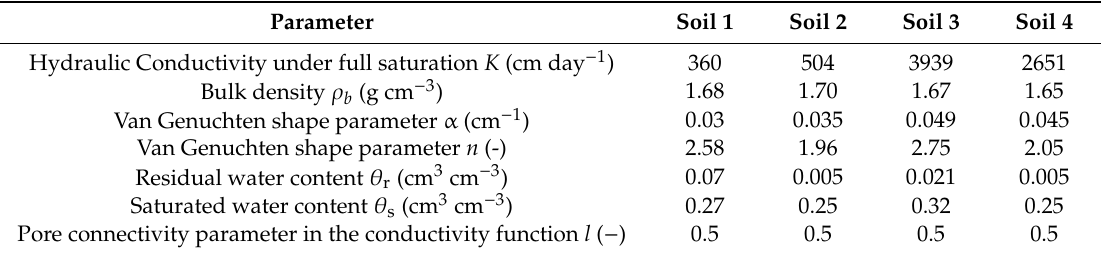
Table 5. Final parameter set for the used soil materials based on inverse solution, the value for the pore connectivity parameter in the conductivity function; here, 0.5 was selected after